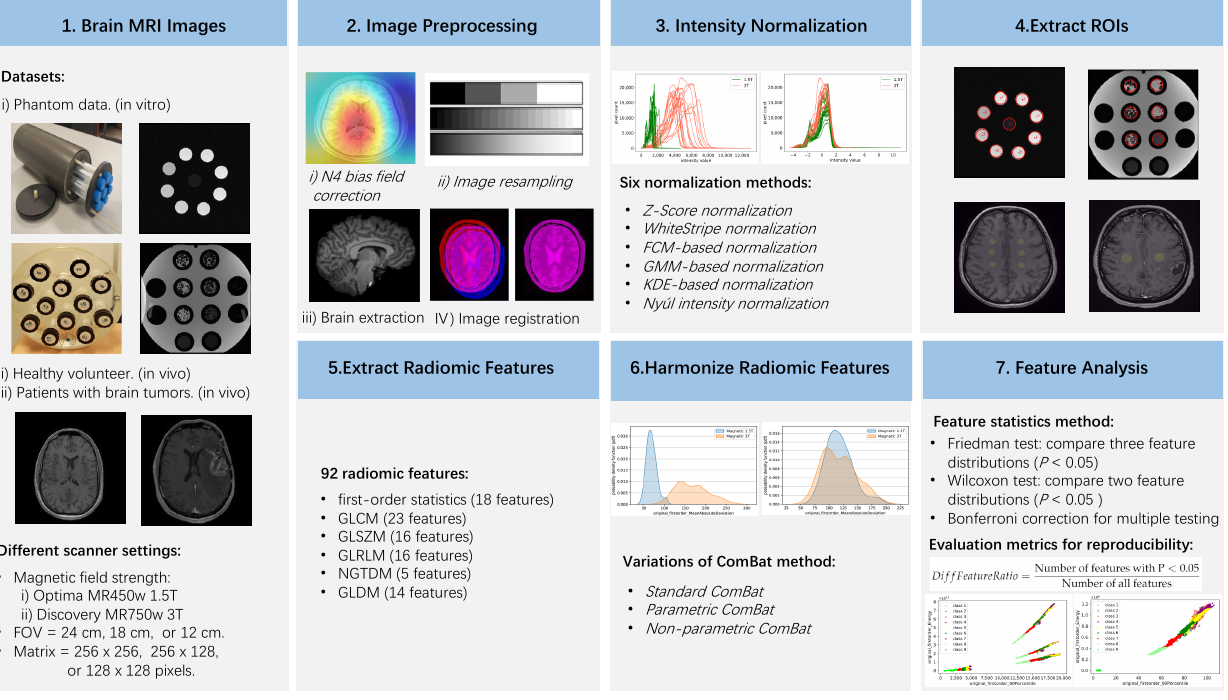
Figure 1. Workflow of our study. The methods in italic are the key factors we investigate for their impacts on the removal of the scanner effects. Phantom data are special, thus N4 bias field correction, brain extraction, image registration, and WM-related intensity normalization methods (WhiteStripe, FCM-based, GMM-based, and KDE-based normalization) were not